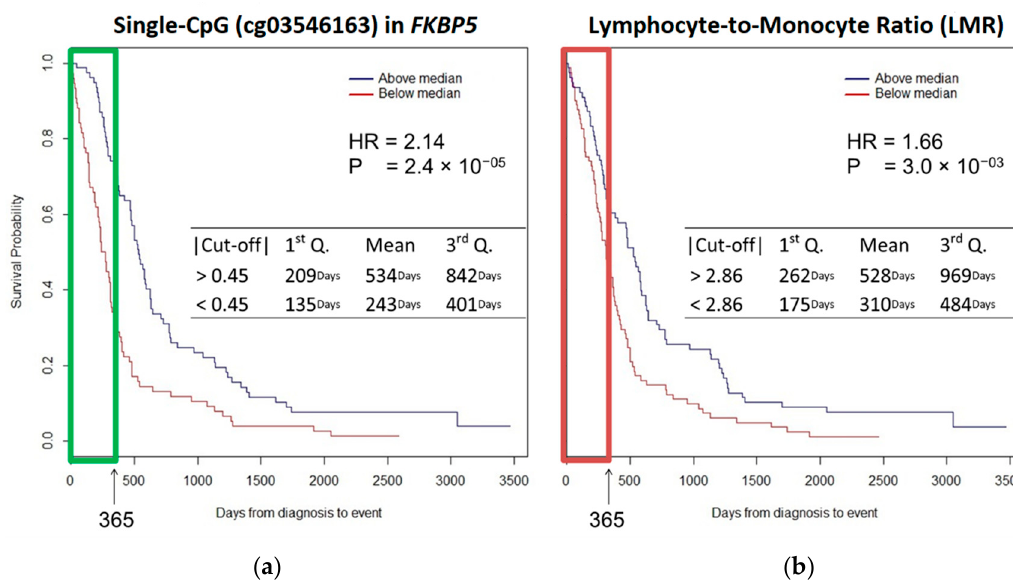
Figure 2. K-M survival curves show ( a ) cg03546163: patients with a DNAm < 0.45 had significantly poor survival compared with a DNAm ≥ 0.45 (mean, 243 versus 534 days; p value < 0.001); ( b ) LMR: patients with values < 2.86 had significantly poor survival compared with patients with values ≥ 2.86 (mean, 310 versus 528 days; p value < 0.001). cg03546163 is an independent marker of prognosis in patients with MPM and performs better than LMR (HR cg03546163 = 2.14 vs HR LMR =